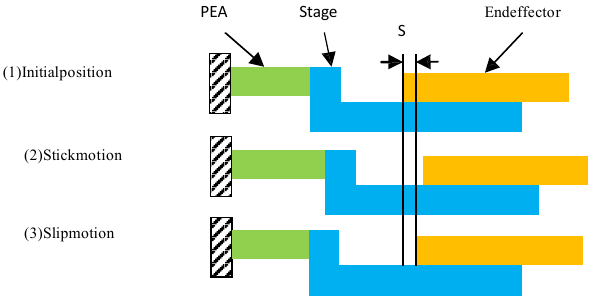
Table 1. Friction characteristics captured by different